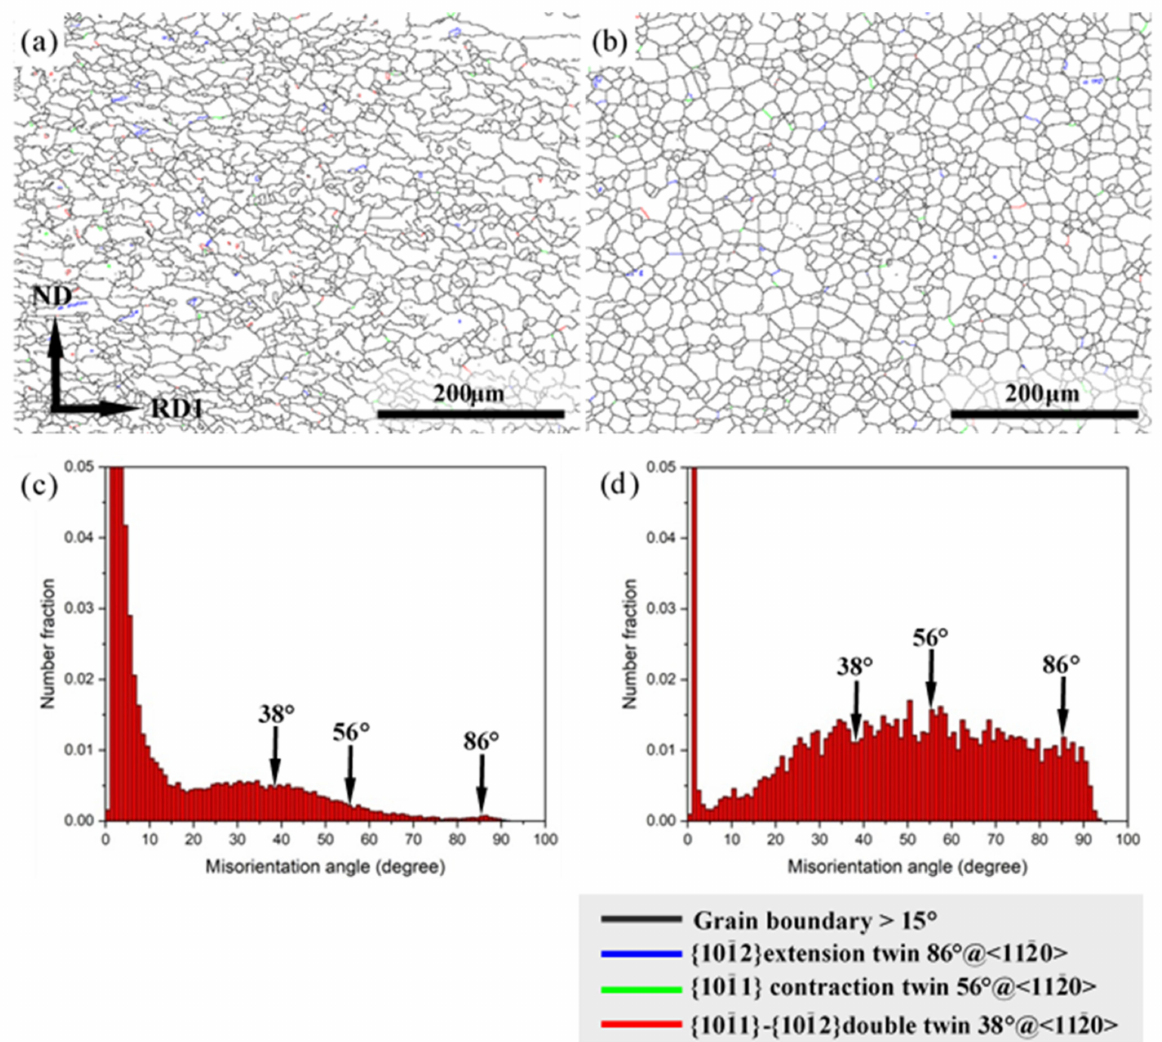
Figure 15. Misorientation angle maps showing various twin boundaries of ( a ) as-rolled and ( b ) as-annealed; misorientation angle distributions of ( c ) as-rolled and ( d ) as-annealed Mg-3Y